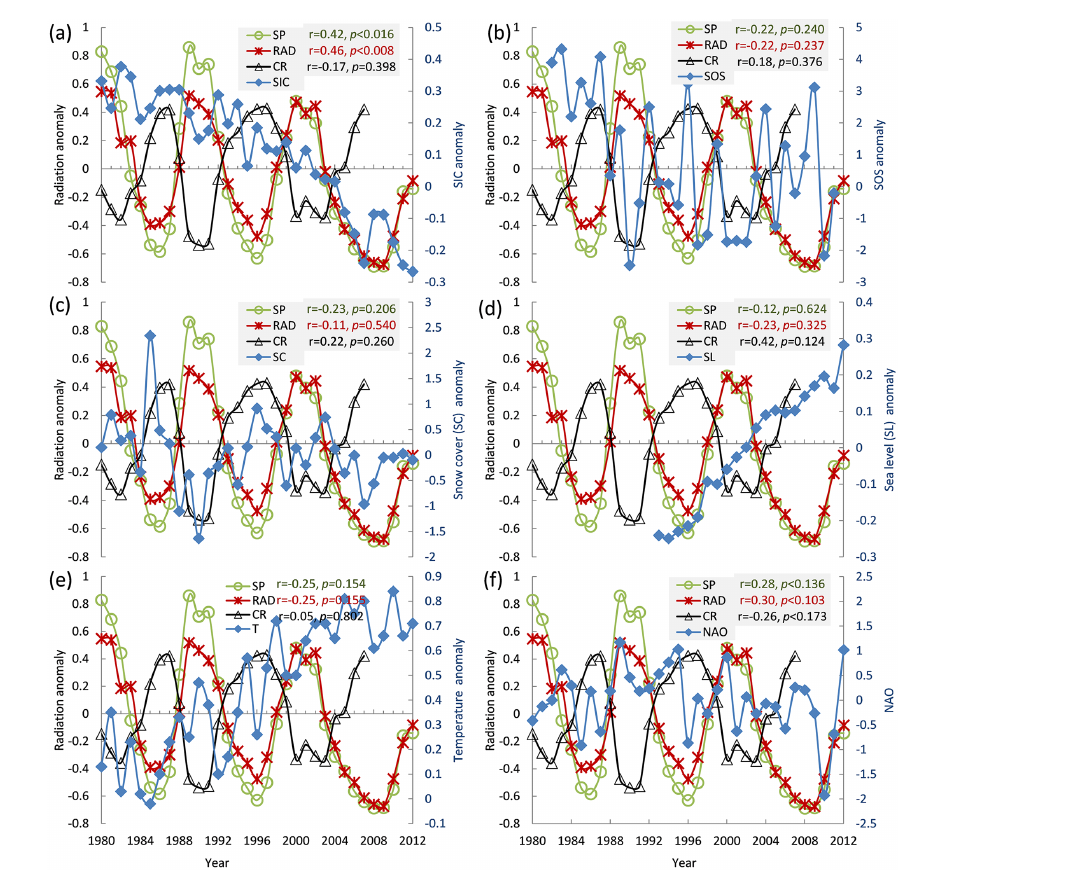
Figure 3. Relationships among temperature, land, cryosphere and ocean indicators, and recent trends in solar radiation, sunspots and cosmic rays. The relationships between anomalies of annual average of daily mean sunspot number (SP), annual average of daily mean solar irradiance (RAD, Wm − 2 ), and the Kiel station annual average of hourly cosmic ray (CR) counts relative to 1980–2007 normals and, (a) sea ice concentration (SIC) 0 (no ice) to 10 (full ice coverage) anomaly of circumpolar Northern Hemisphere region ( > 31 ◦ N) relative to 1993–2012 normals, (b) start of growing season (SOS) day anomaly of northern ecosystems ( > 45 ◦ N) relative to 1988–2007 normals (ref. Barichivich et al., 2013, modified), (c) snow cover (SC) 10 6 km 2 anomaly of Northern Hemisphere relative to 1993–2012 normals, (d) sea level (SC) 10 2 mm anomaly of Northern Hemisphere relative to 1993–2012 normals, (e) surface temperature anomaly of